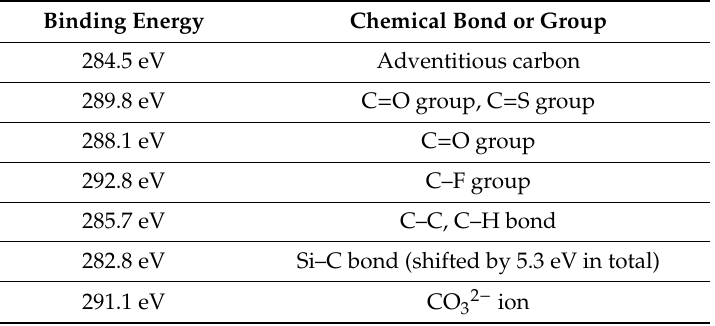
Table 1. Fit components and their associated bonds of the carbon